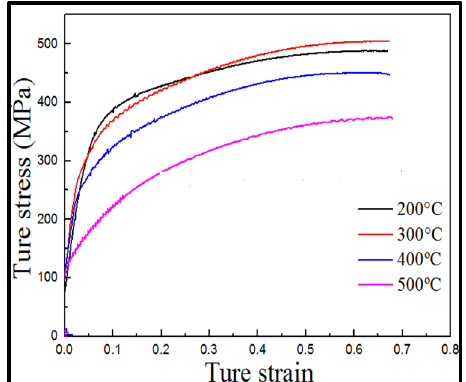
Figure 3. Curves showing true stress–true strain distribution for different temperatures.